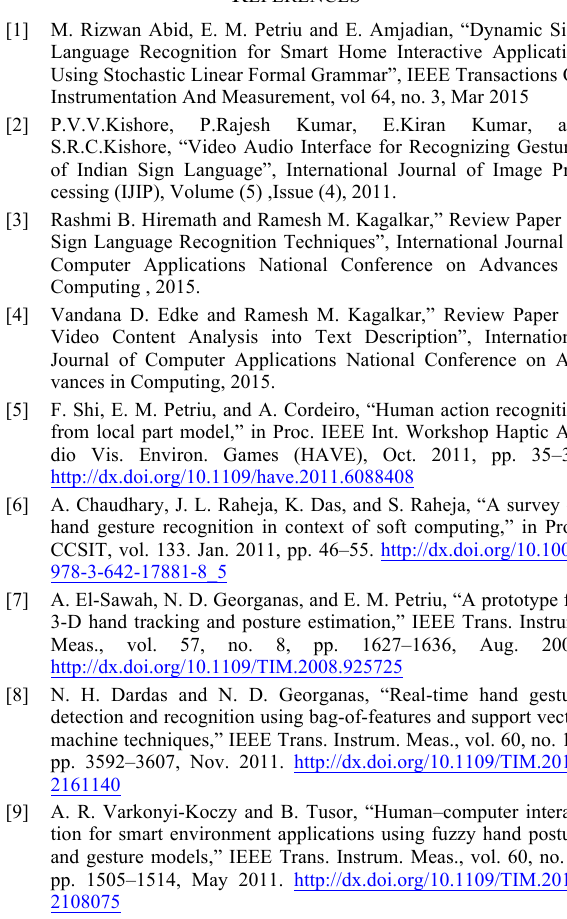
Figure 3. Time comparison for feature extraction process R